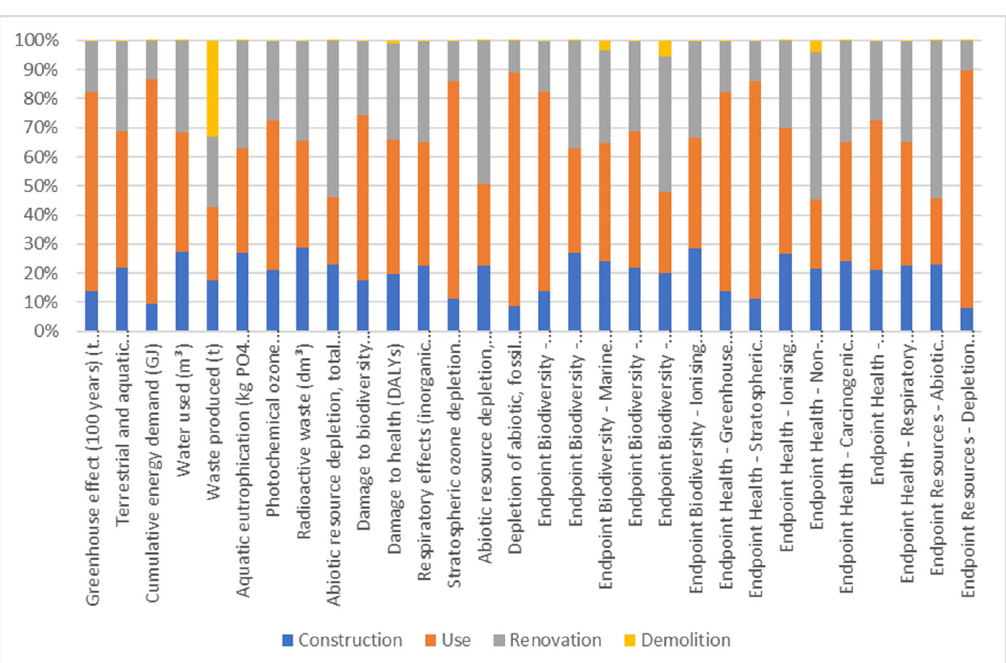
Figure 13. This analysis focuses on 33 impact indicators representative of the sum of the